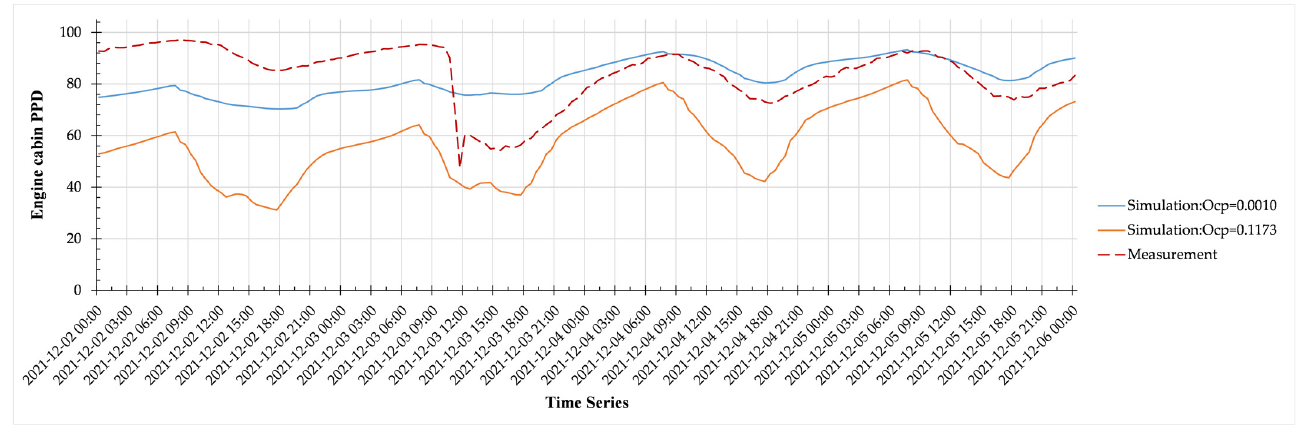
Figure B6. Engine cabin: predicted percentage dissatisfied between 2 and 5 December 2021.